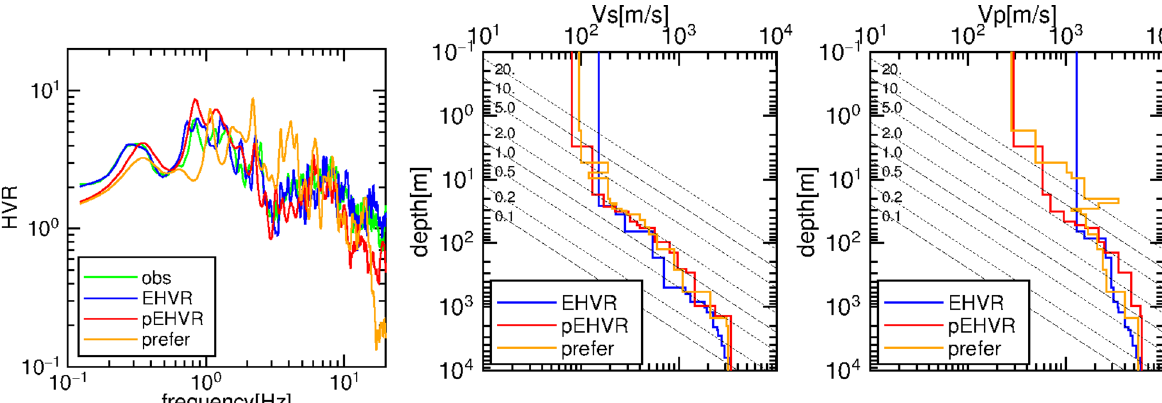
Fig. 5 Comparisons of the theoretical EHVRs by the inverted models with the observed EHVR (on the left) and the resultant S- and P-wave velocity profiles (on the right side). The red and blue lines are the result of the velocity models inverted for the converted pEHVR and the observed EHVR in Step-2, respectively, while the green line on the left is the observed EHVR. Orange lines are those of the preferred model distributed by the CBP-ESG6. The inclined dashed and dotted lines on velocity models show resonant frequencies of the corresponding layer interfaces based on one quarter wavelength